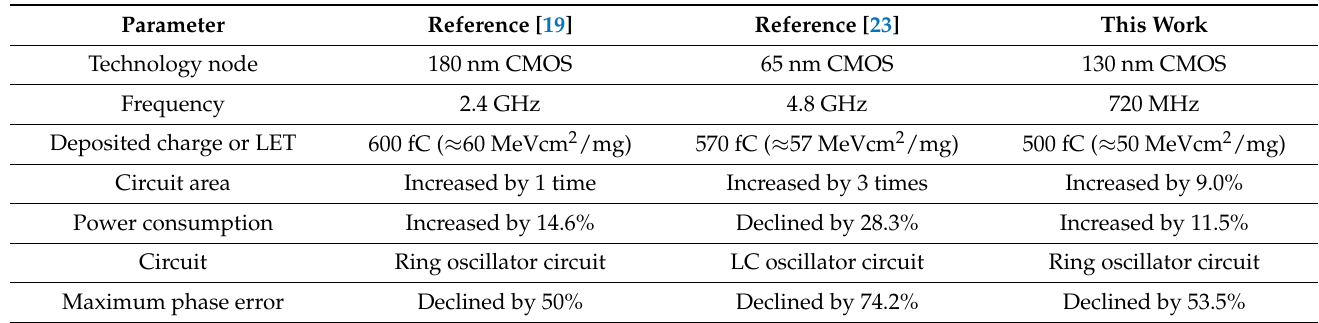
Table 2. Comparison with other